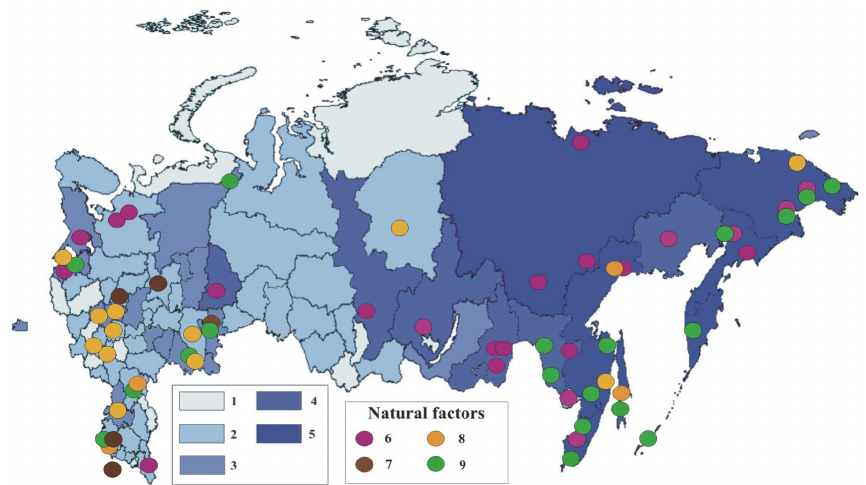
Fig. 5. Frequency of breakdowns in heat supply systems (average annual number of events): 1 – less than 0.1; 2 – 0.1–0.3; 3 – 0.4–0.6; 4 – 0.7–0.9; 5 – 1 and more; 6 – hard frost, 7 – landslide; 8 – snow; 9 – strong wind. taking into account the large length of power lines (more